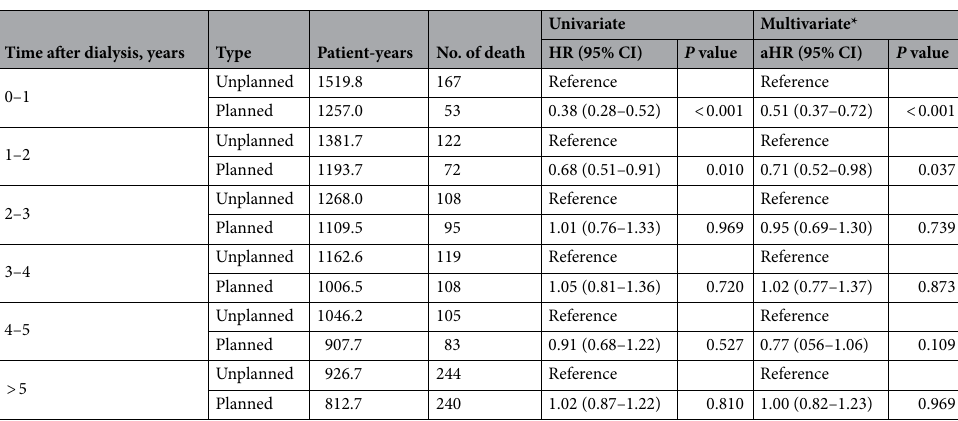
Table 2. Hazard ratios for annual mortality of planned dialysis by Cox proportional hazard model. *Adjusted for age, sex, mCCI, serum hemoglobin, albumin, calcium, phosphate, 24-h urine volume, work status, insurance, marital status, and ambulation status. HR hazard ratio, CI confidence interval, aHR adjusted hazard ratio, mCCI modified Charlson comorbidity